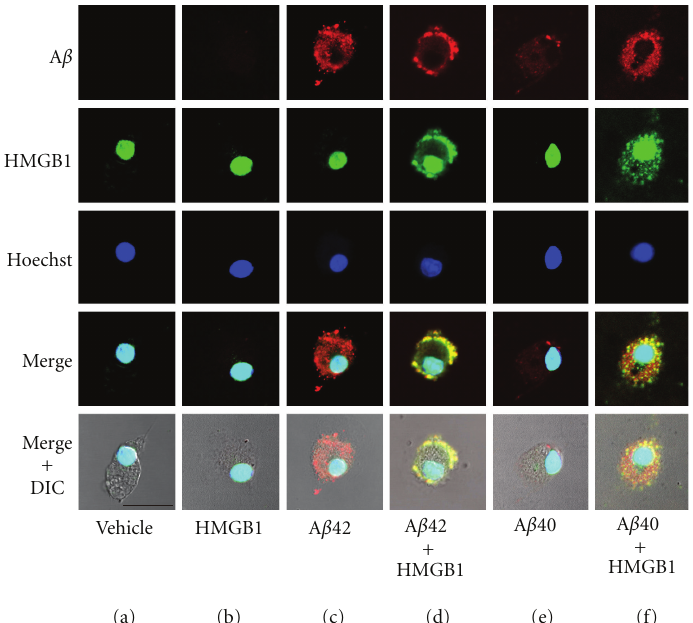
Figure 2: E ff ect of exogenous HMGB1 on microglial A β phagocytosis analyzed by laser confocal microscopy. Rat microglia were incubated with the vehicle (a), HMGB1 (b), A β 42 (c), A β 42 and HMGB1 (d), A β 40 (e), or A β 40 and HMGB1 (f) for 12 h. Fixed cells were further incubated with the anti-A β antibody (red), anti-HMGB1 antibody (green), and Hoechst 33258 (dye for nuclei; blue); they were analyzed using a laser scanning confocal microscope. DIC: di ff erential interference contrast. Scale bar = 20 μ m for all panels.